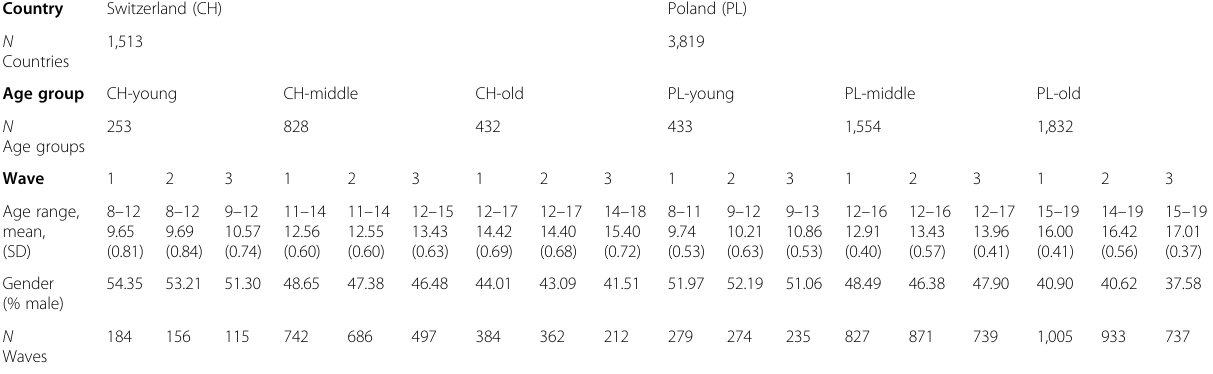
Table 2 Study design: sample sizes, age, and gender distributions per country, age cohorts, and